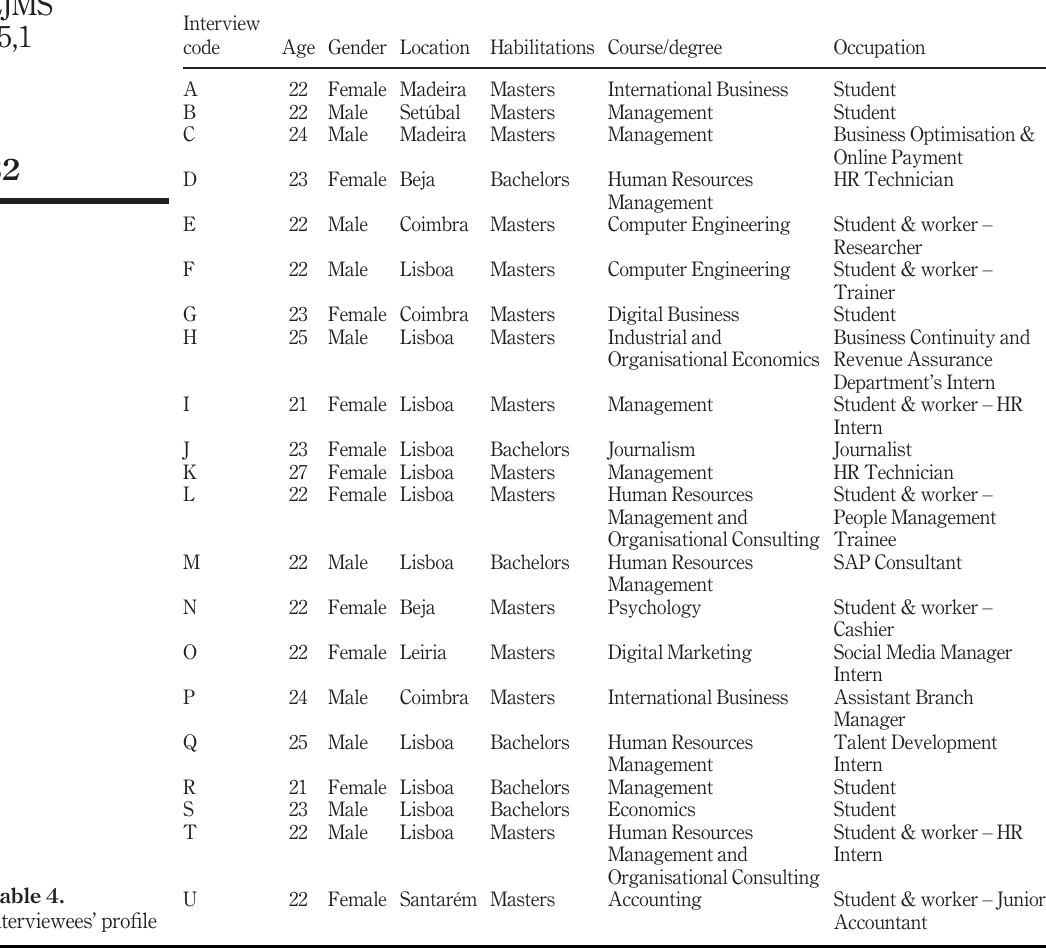
Table 4. Interviewees ’ pro fi